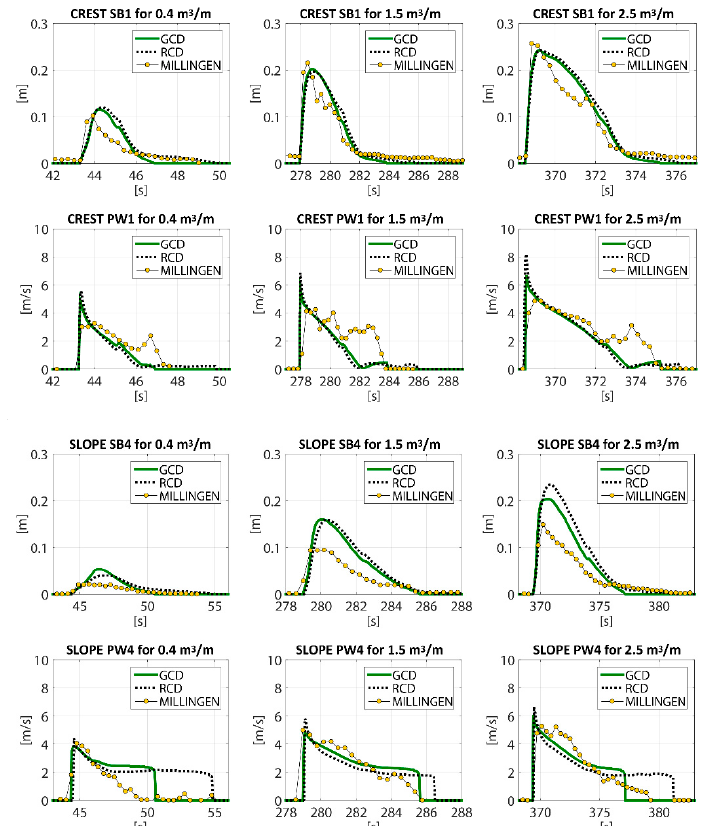
Figure A3. Depth and velocity time series for the location on the crest ( upper 6 plots) and the side slope ( lower 6 plots) of different wave volumes from the RCD and GCD model and the measured values for the same waves during the Millingen experiment.